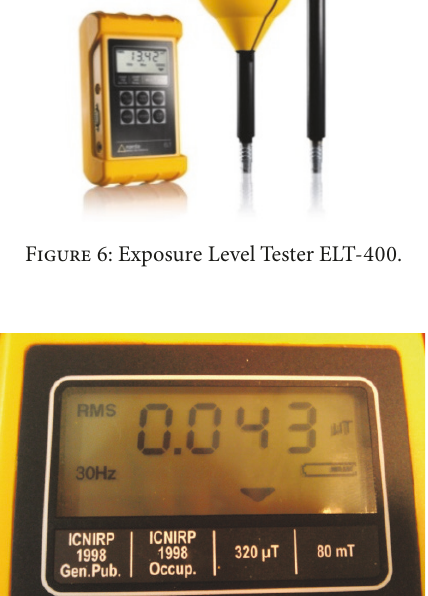
Figure 7: ELT-400